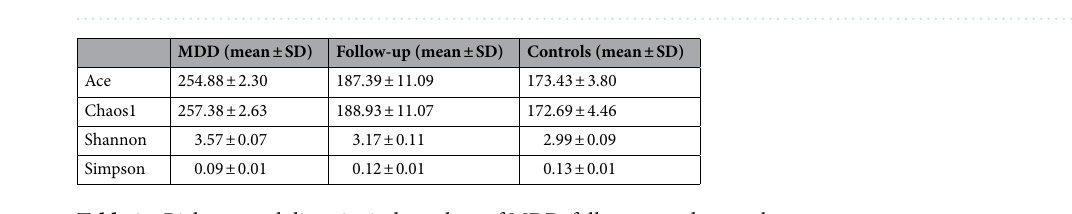
Table 2. Richness and diversity index values of MDD, follow-up and